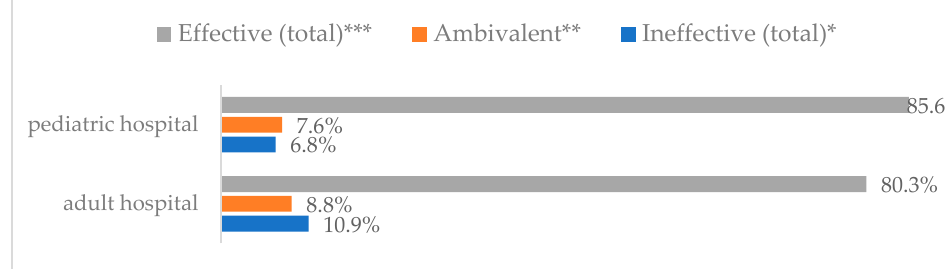
Figure 7. Hand washing to prevent influenza virus infection by age ( N = 905). *Sum of responses: completely ineffective, ineffective, rather ineffective; **Response: neither ineffective nor effective; ***Sum of responses: rather effective, effective, completely effective.